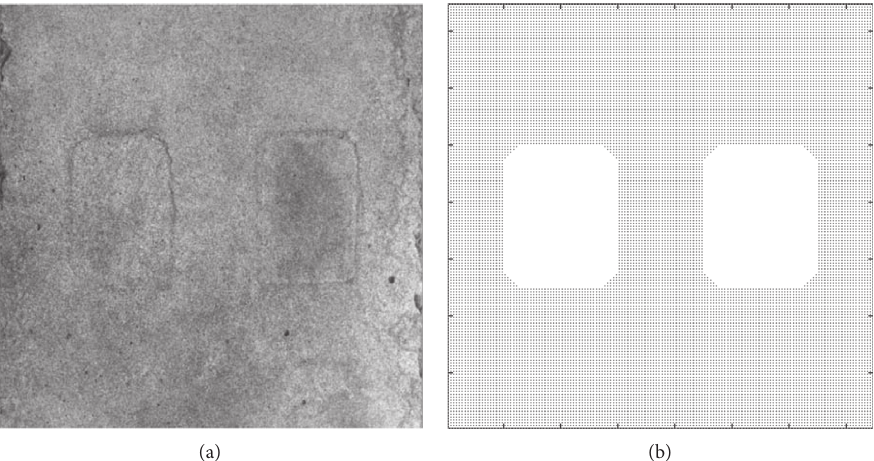
Figure 8: Physical and numerical specimens of the double-aggregate specimen: (a) physical specimen; (b) numerical specimen.